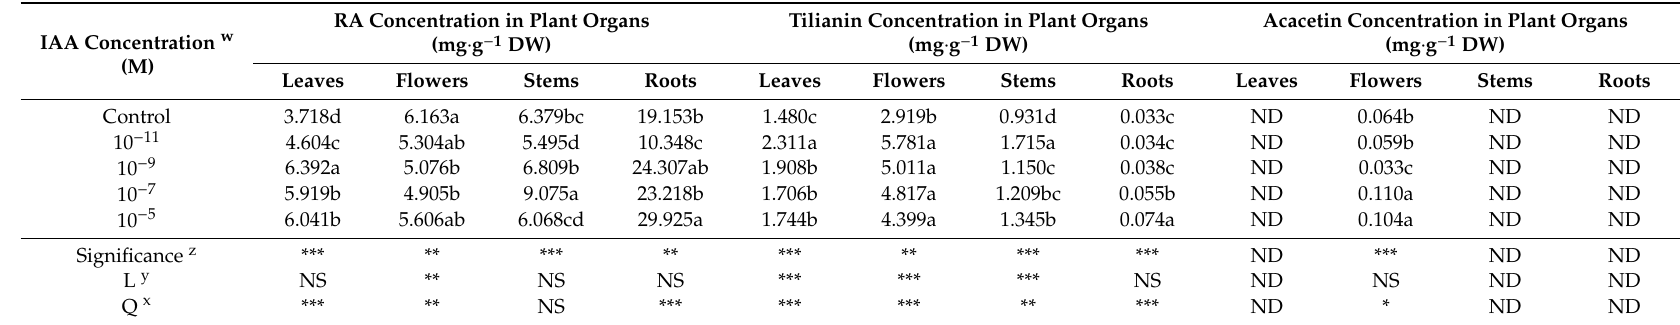
Table 2. Rosmarinic acid (RA), tilianin, and acacetin concentrations (mg · g − 1 DW) in flowers, leaves, roots, and stems of A. rugosa subjected to the control (without IAA) and four IAA treatments.